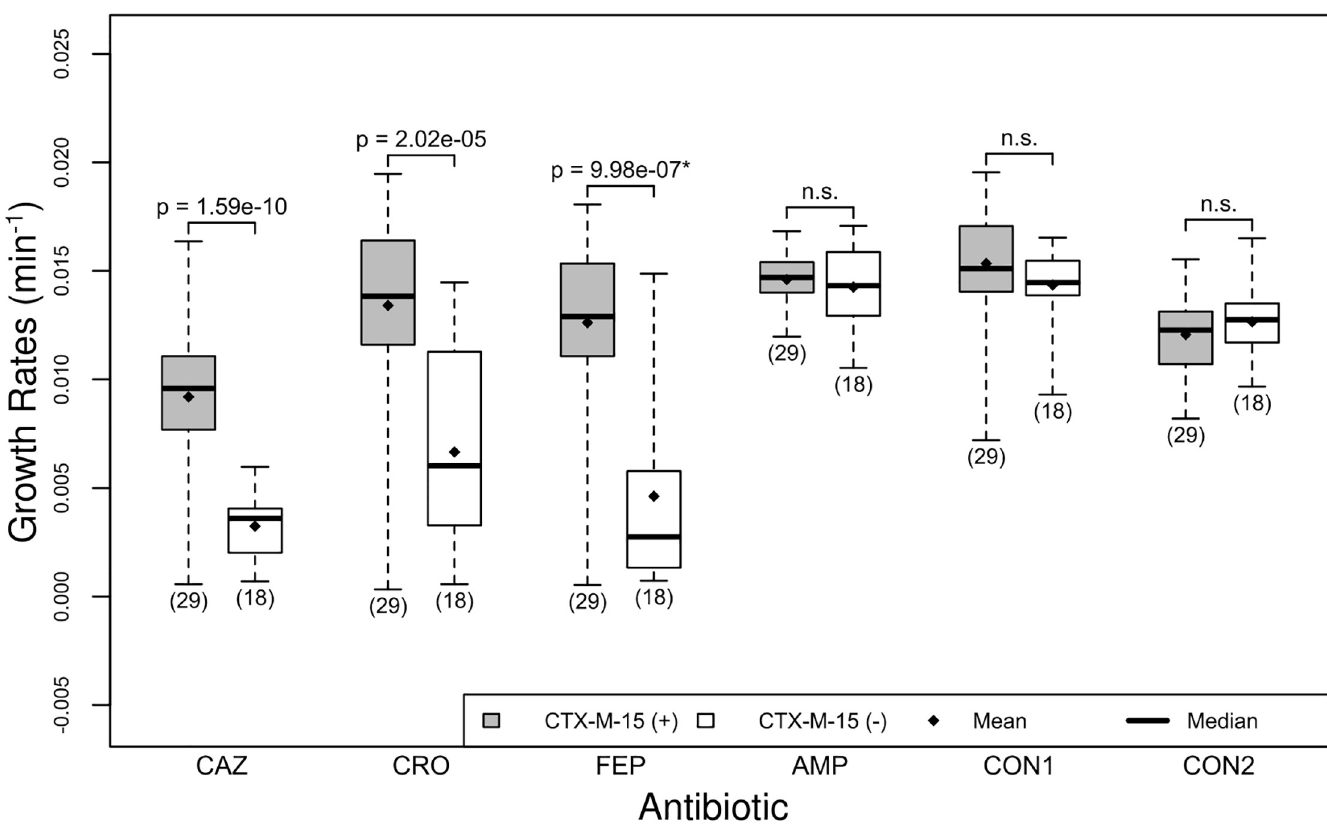
Fig 3. Isolates with CTX-M-15 exhibit higher growth rates in the presence of cephalosporins. There are two boxplots per antibiotic, the first (gray) shows the distribution of growth rates for isolates that have the CTX-M-15 gene, labeled CTX-M-15 (+) and the second (white) shows the distribution of growth rates for isolates that do not have the CTX-M-15 gene, labeled CTX-M-15 (-). The n.s. indicates the difference in growth rates is not significant. Abbreviations for controls: CON1, the control growth rates for the experiment CAZ, CRO and FEP; CON2, the control growth rates for the experiment AMP. See Fig 1 for interpretation of boxplots.